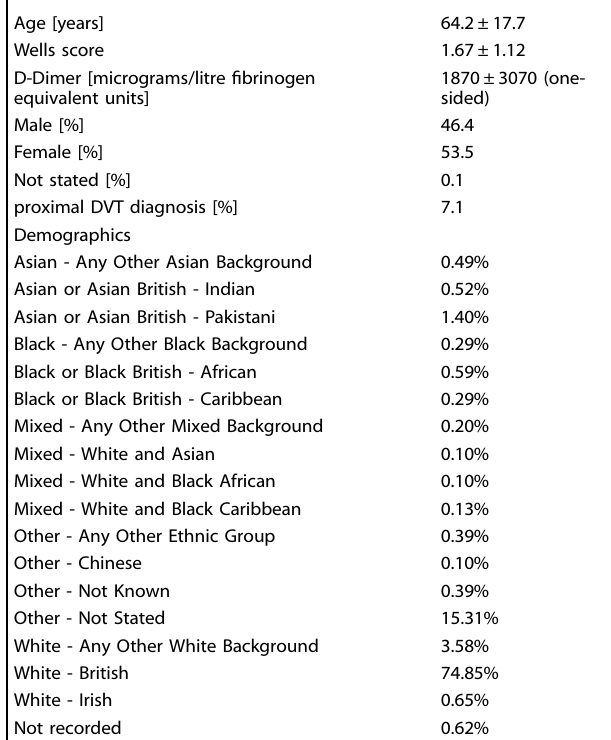
Table 1. General population overview for model training and external validation